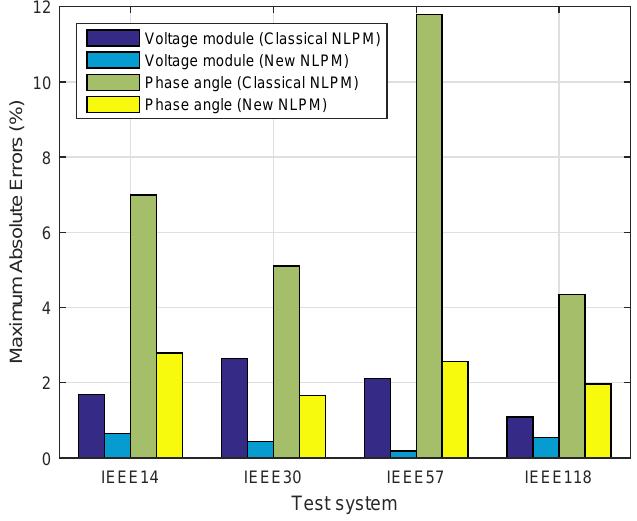
Figure 6. Maximum absolute errors for voltage magnitudes and phase